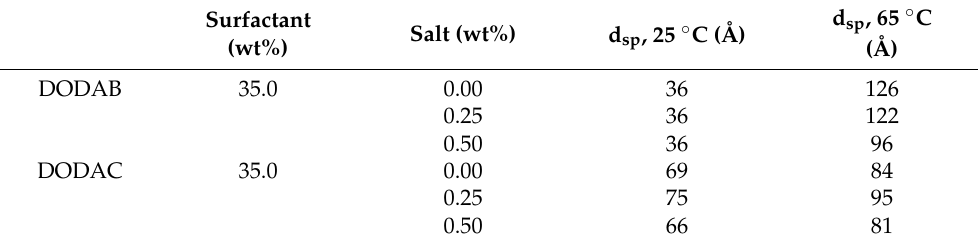
Table 5. Values of the interlamellar spacing (d sp ) of 35 wt% DODAB and 35 wt% DODAC bilayers in the presence of 0.25 wt% and 0.50 wt% NaBr and NaCl, respectively. The measurements were performed at temperatures below (25 ◦ C) and above (65 ◦ C) the main phase transition